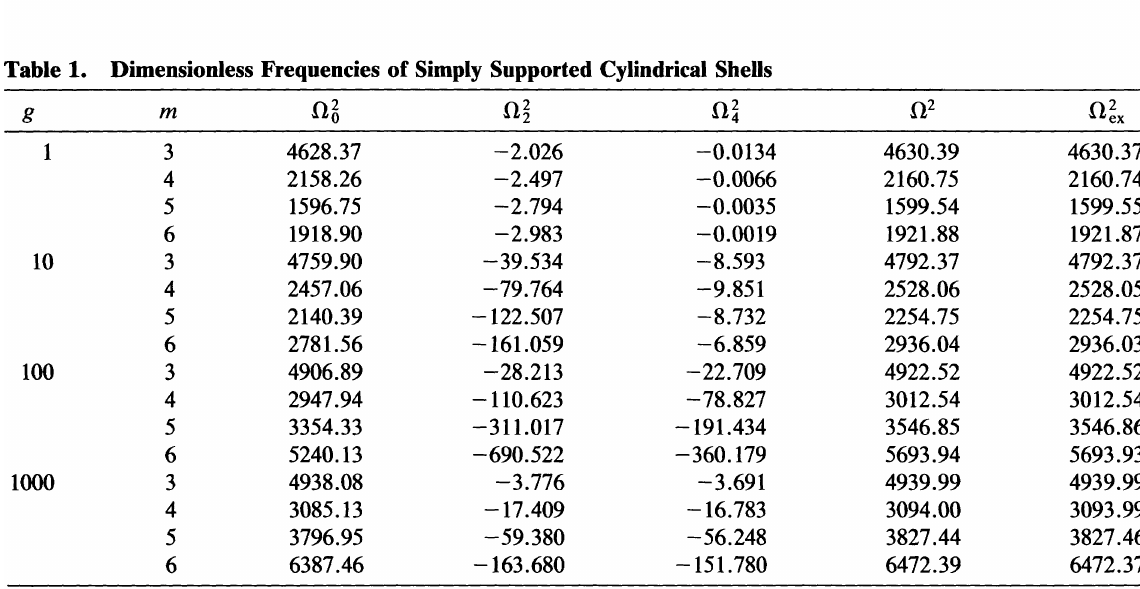
Table 1. Dimensionless Frequencies of Simply Supported Cylindrical